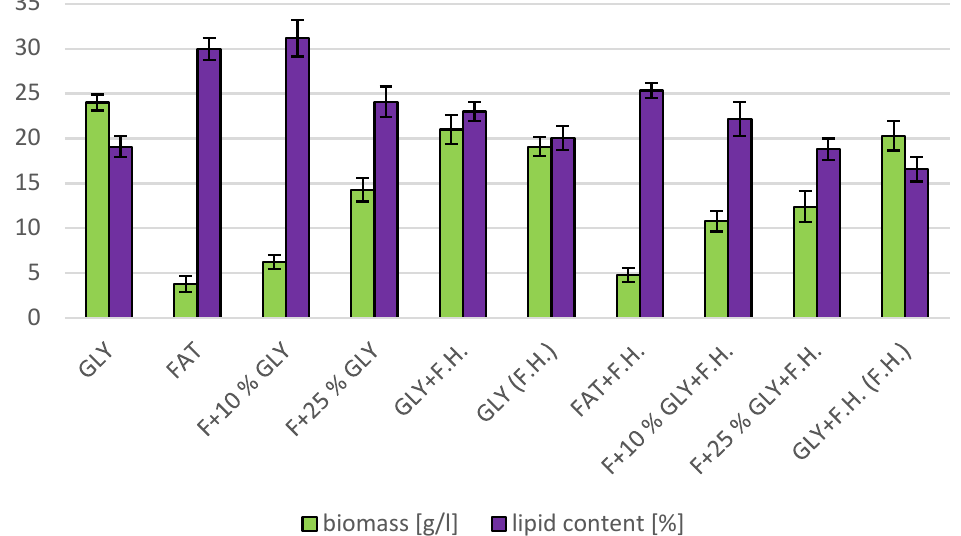
Figure 5. Lipid and biomass content in yeast strain Rhodotosporidium toruloides in conditions of C/N ratio 50.